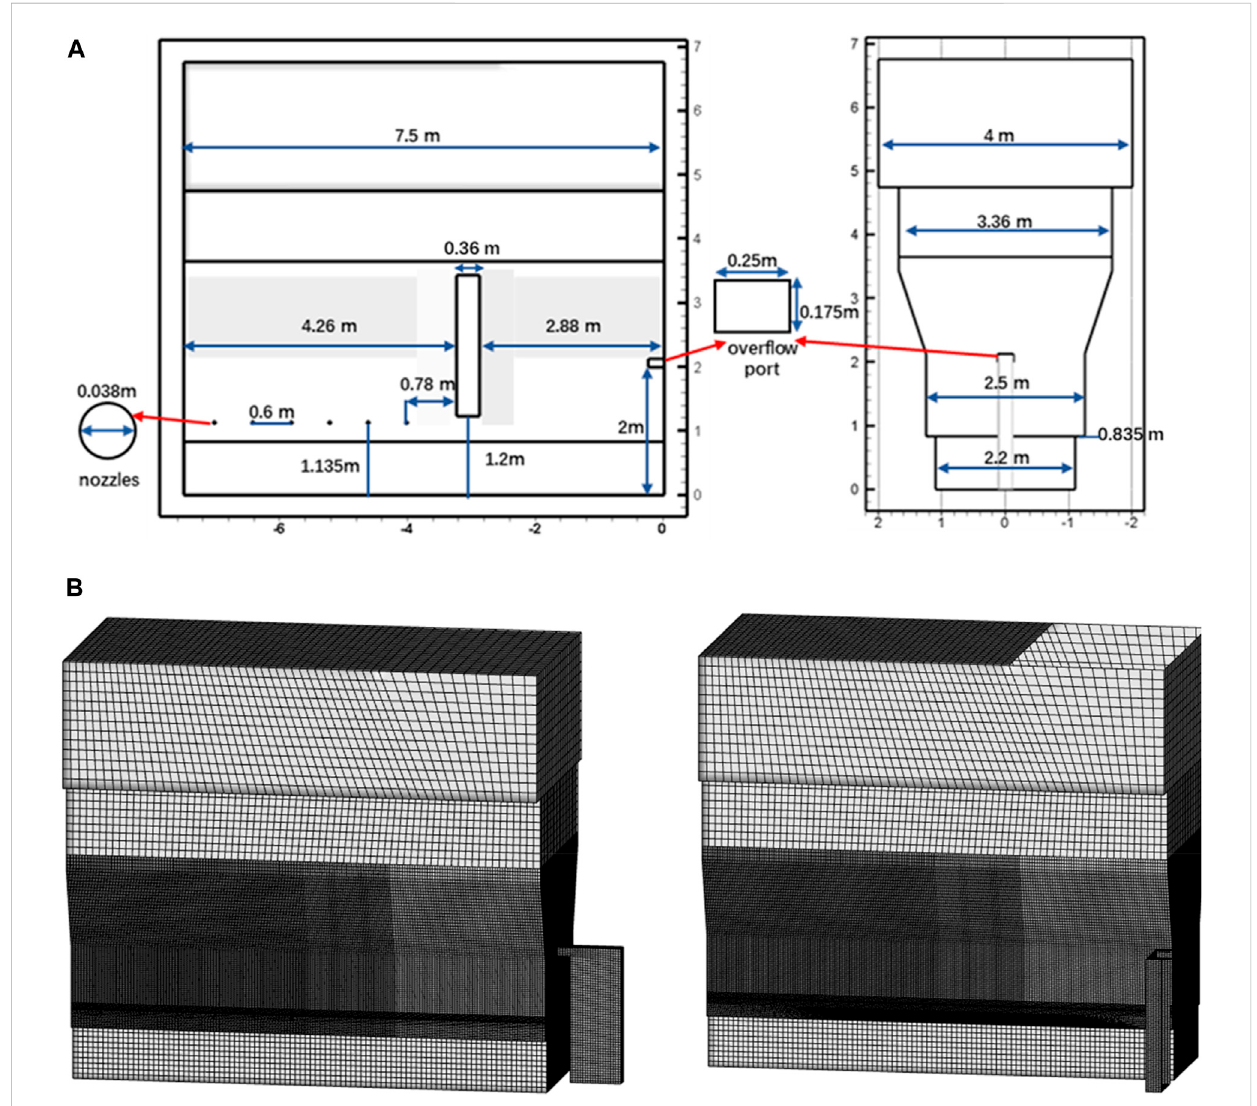
FIGURE 2 Physical model and mesh division of numerical simulation. Physical model (A) and mesh division (B) of numerical simulation.